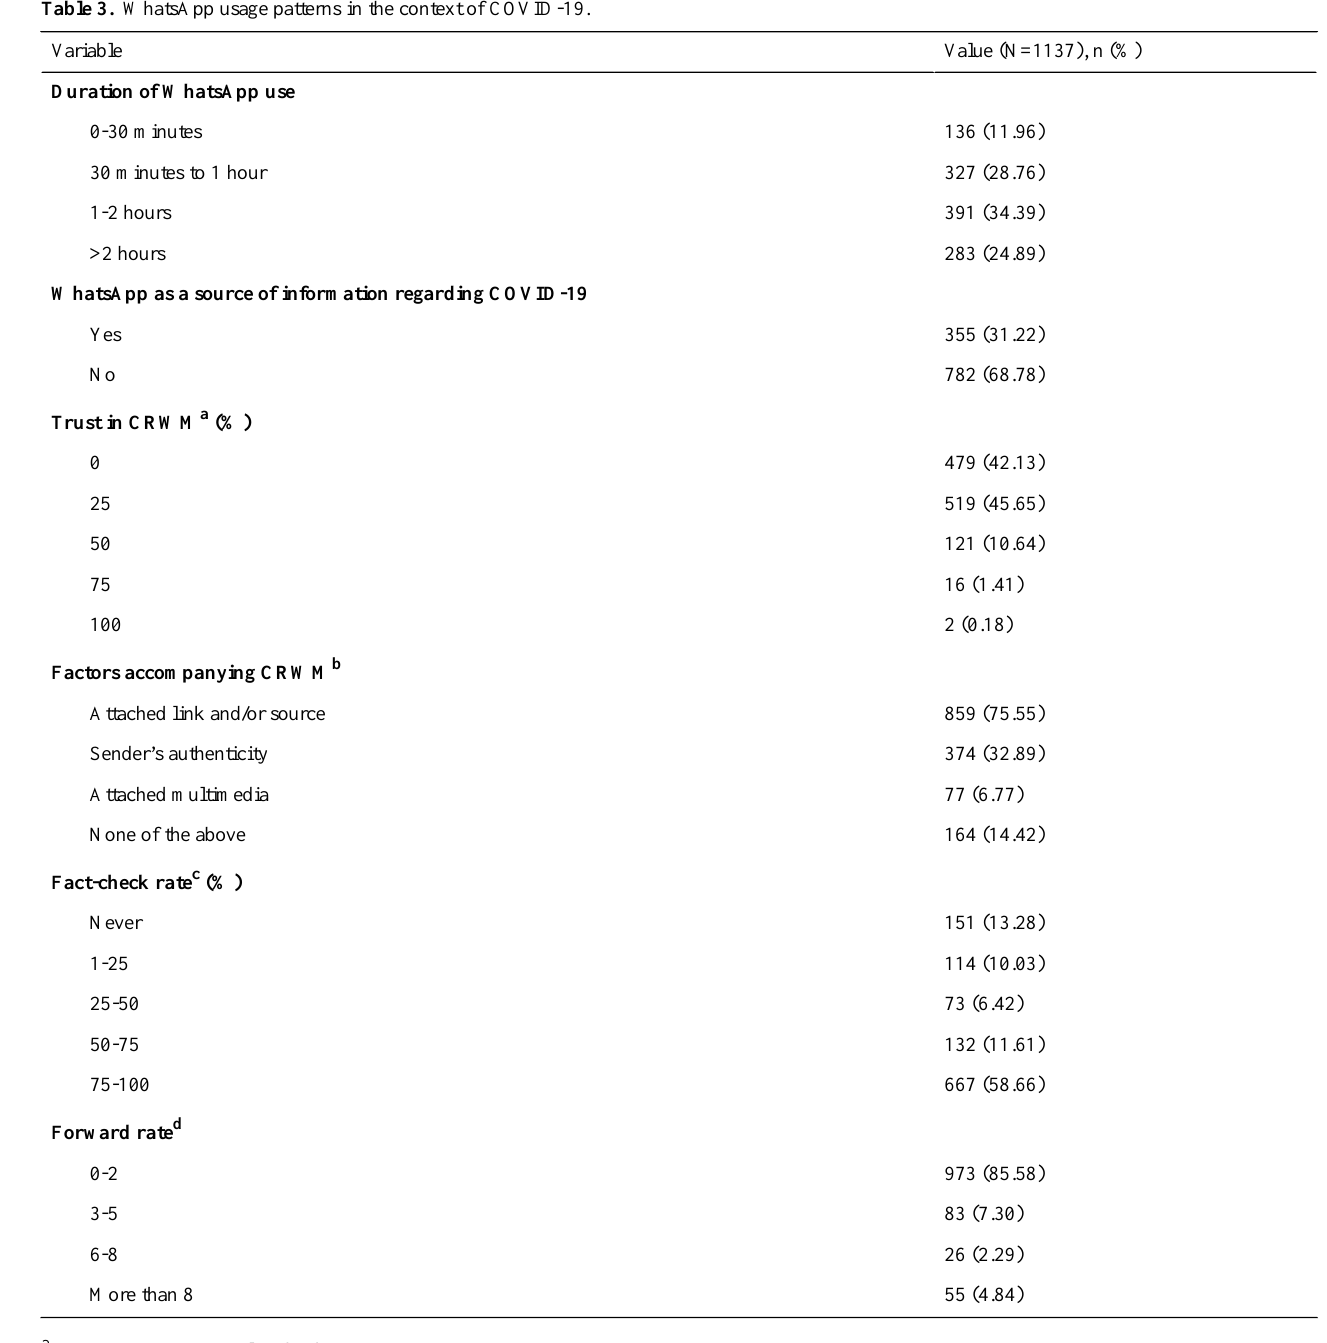
Table 3. WhatsApp usage patterns in the context of